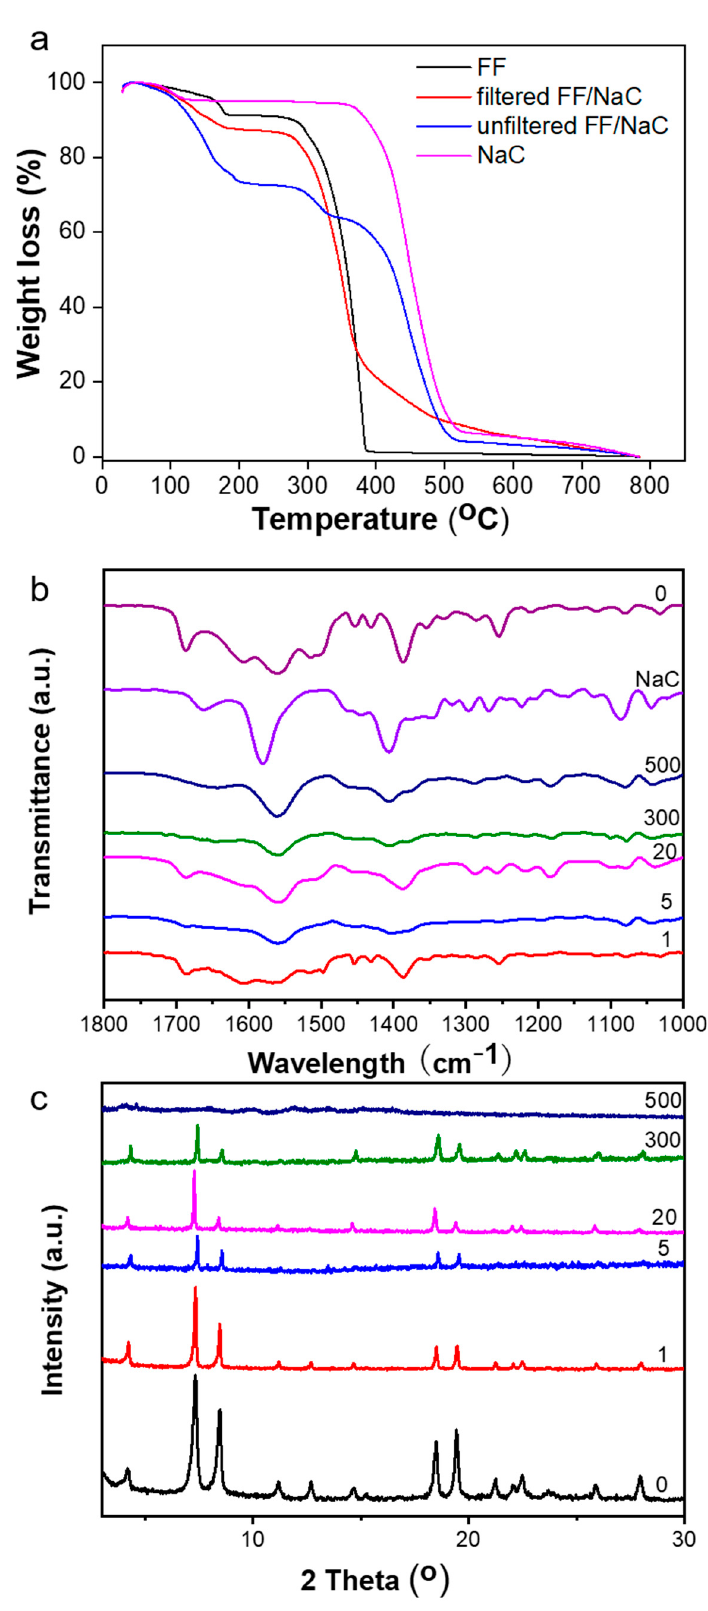
Figure 4. ( a ) The TGA curves of pure FF, pure NaC, and FF/NaC mixtures. ( b ) FTIR and ( c ) XRD spectra of FF/NaC mixtures at NaC concentrations of 0, 1, 5, 20, 300 and 500 mmol/L, with a fixed FF concentration of 10 mmol/L .